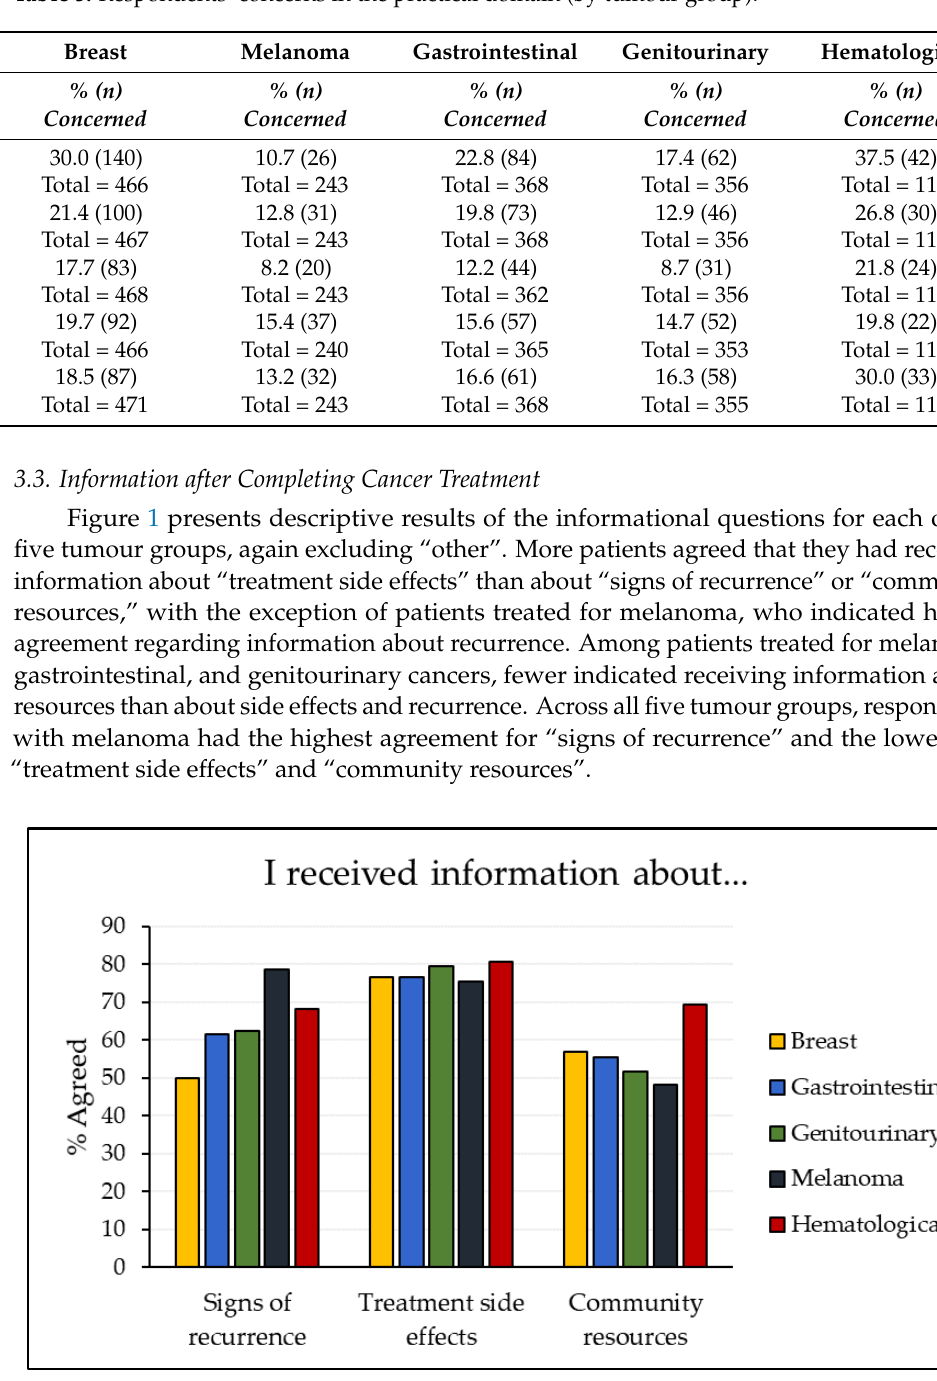
Three binary logistic regression models were run for each tumour group, one with each of the group’s top three concerns as the outcome. Odds ratios and associated significance values are presented in Tables